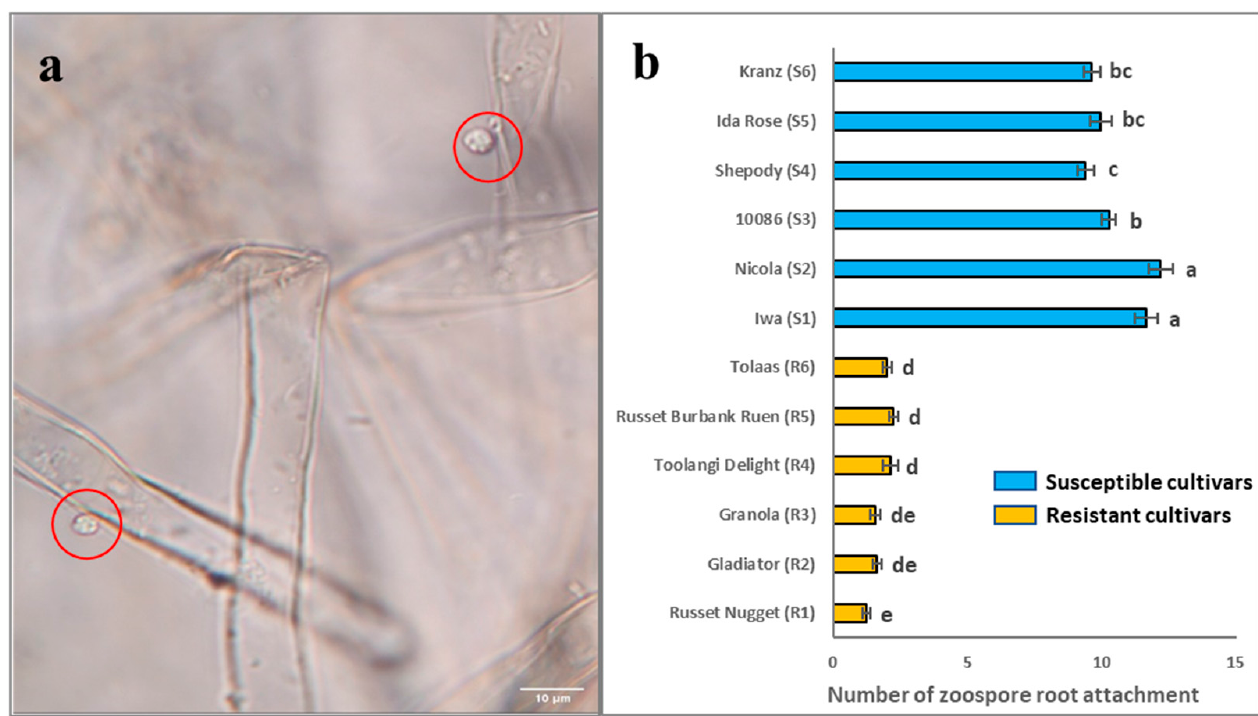
Figure 1. Zoospore root attachment of twelve potato cultivars. ( a ) Zoospore (in red circle) attached to potato root; ( b ) statistical analysis of zoospore root attachment severity scores of twelve potato cultivars ‘Iwa (S1)’, ‘Nicola (S2)’, ‘10086 (S3)’, ‘Shepody (S4)’, ‘Ida Rose (S5)’, ‘Kranz (S6)’, ‘Russet Nugget (R1)’, ‘Gladiator (R2)’, ‘Granola (R3)’, ‘Toolangi Delight (R4)’, ‘Russet Burbank Ruen (R5)’, and ‘Tolaas (R6)’ at 48 h after inoculation. Three independent biological replicates (from different plants) were assessed for each cultivar. Horizontal bars represent the standard error ( n = 3). p < 0.001. LSD (0.05) = 0.73. The blue bars represent all the susceptible cultivars (S), and the yellow bars represent all the resistant cultivars (R) to zoospore root attachment. Bars that are labelled with different letters indicate values that are significantly different from each other.